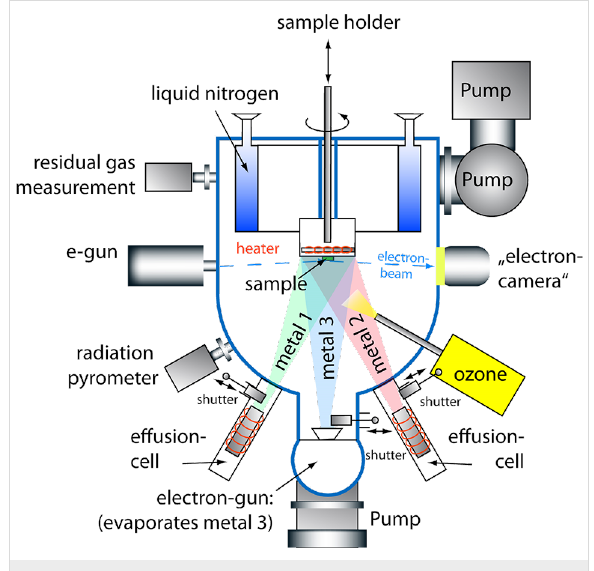
Figure 2: Sketch of the growth chamber.